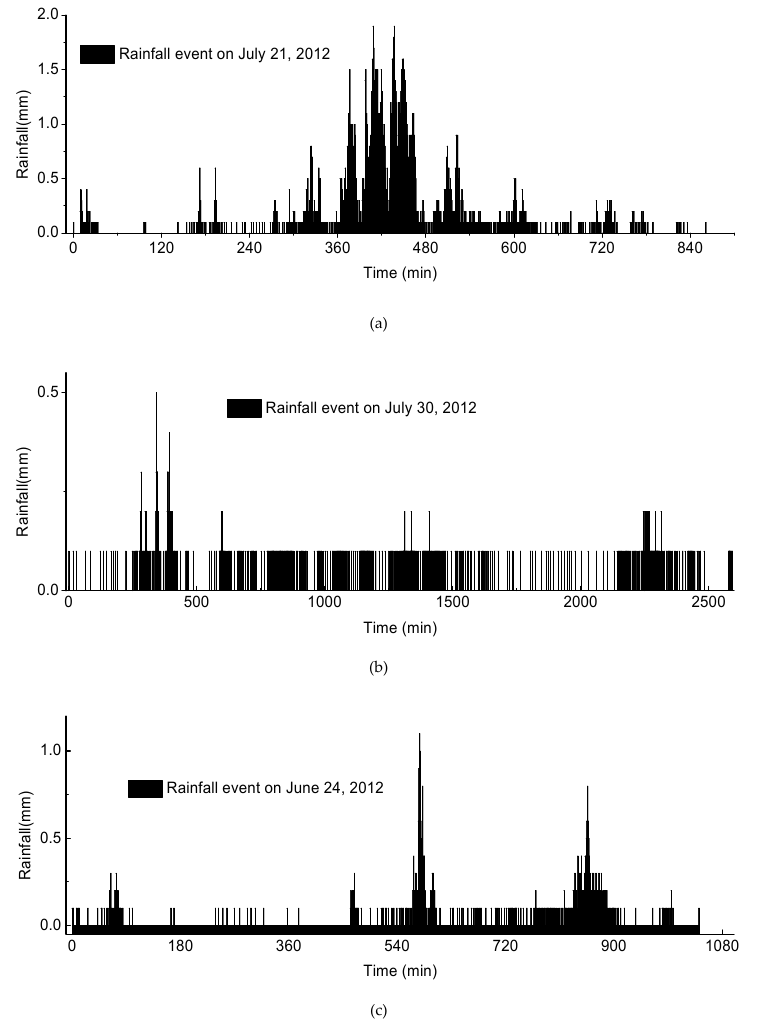
Figure 5. The data of the three rainfall processes: ( a ) rainfall event on July 21, 2012, ( b ) rainfall event on July 30, 2012, and ( c ) rainfall event on June 24, 2012.